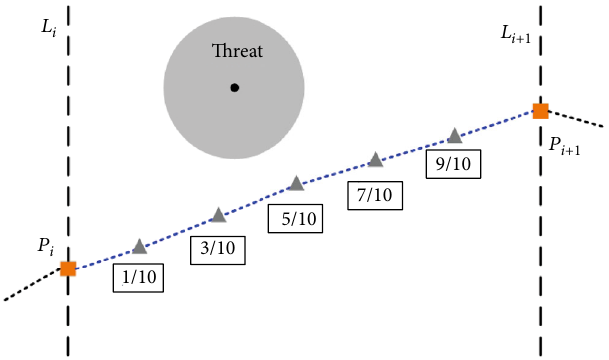
Figure 3: Schematic diagram of fl ight cost